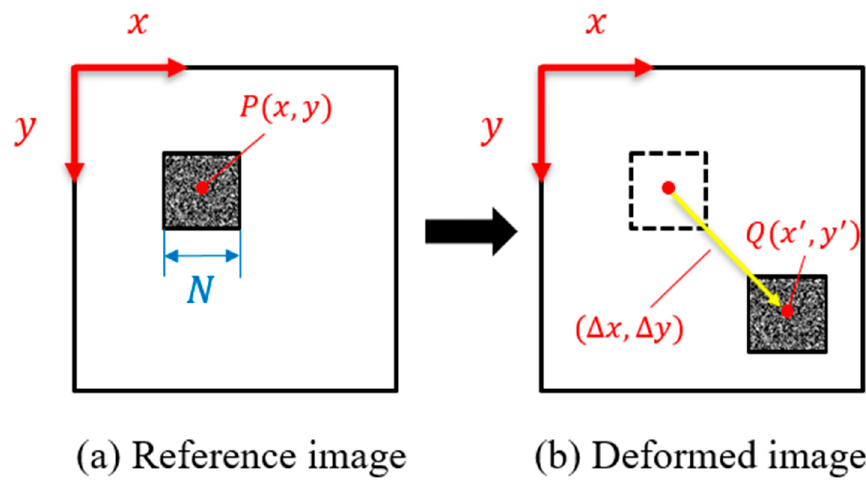
Figure 2. Moving points tracked by DIC.